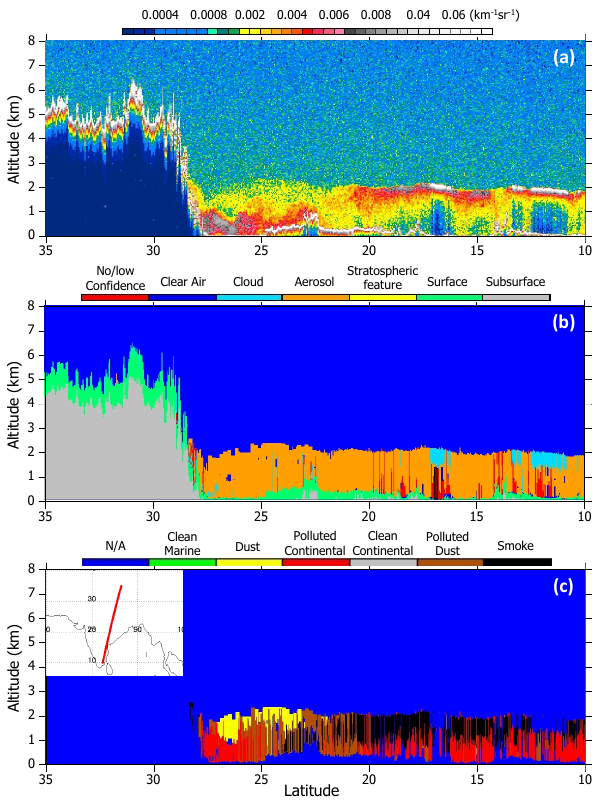
Fig. 6. a) Total attenuated backscatter at 532nm, b) the vertical feature mask and c) the aerosol subtypes from CALIPSO (version 3.01 data) on 1 January 2007 along a transect crossing Eastern IGP showing the low altitude aerosols over this area. The transect is shown in the inset of the bottom